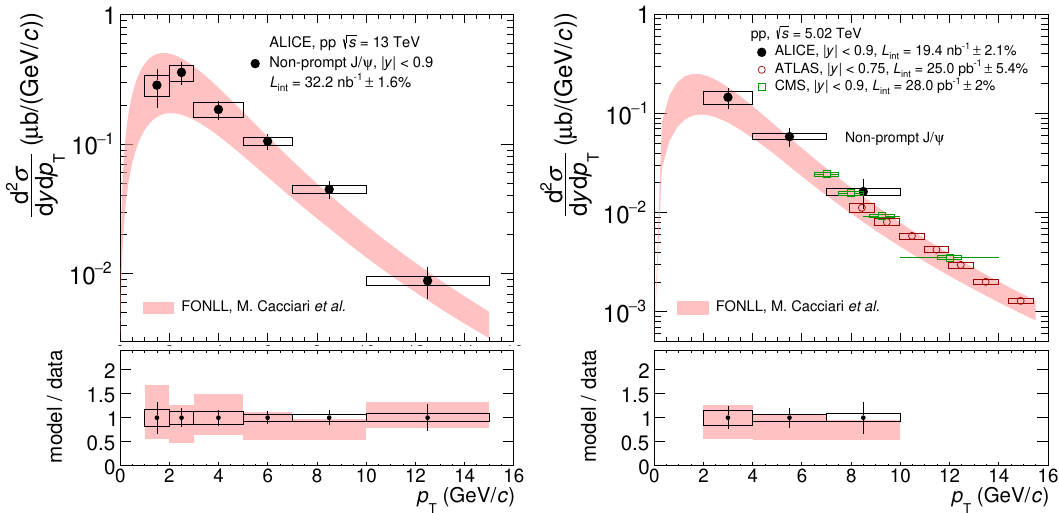
√ Figure 3 . The d 2 σ of non-prompt J /ψ in pp collisions at s = 13 TeV (left panel) and 5.02 TeV d y d p T √ (right panel) as a function of p T . The measurement at s = 5.02 TeV is compared with similar measurements from CMS [17] and ATLAS [16] collaborations at high p T . The error bars (boxes) represent the statistical (systematic) uncertainties. Uncertainties due to the luminosity are not included in the boxes. The results are compared with the FONLL calculations [60, 61] at both energies. Bottom panels show the ratios FONLL to ALICE data. The uncertainty band represents the relative uncertainty from the model whereas the bars and boxes centered around unity refer to relative statistical and systematic uncertainties on ALICE data points,